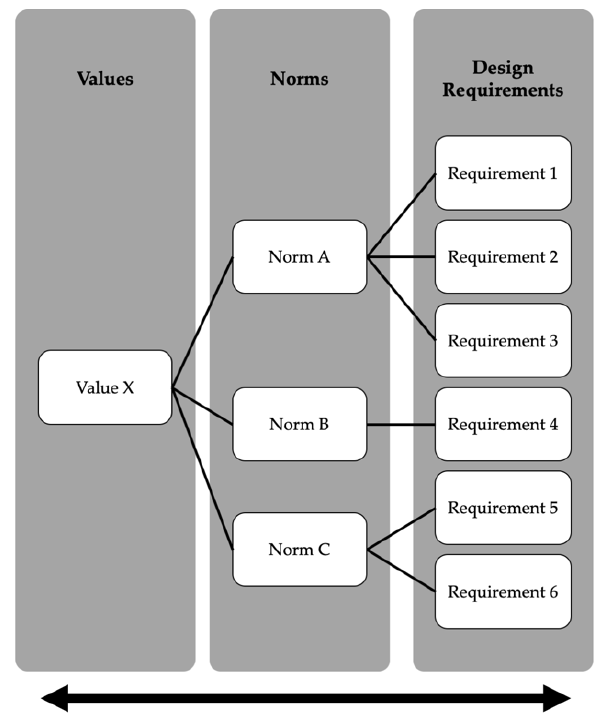
Figure 8. Bi-directional value-norm-requirement hierarchy. 534